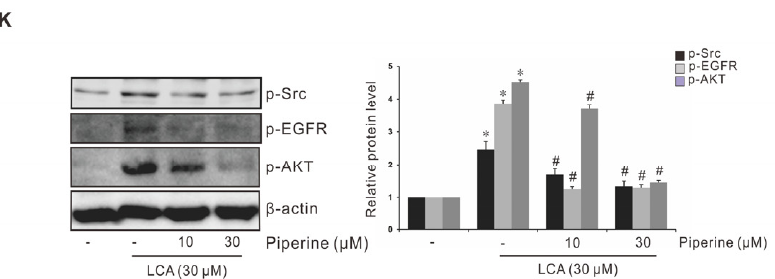
Figure 3. Piperine Inhibits LCA-Induced IL-8 Expression by Suppressing the Activation of ERK1/2, Src, AKT, and EGFR Signaling Pathways. ( A ) HCT-116 cells were pretreated with 30 µ M concentration of SB-203580 (SB), 30 µ M concentration of PD-98059 (PD), and 30 µ M concentration of JNKi for 1 h, and incubated with 30 µ M concentration of LCA for 4 h. Subsequently, the IL-8 mRNA level was measured through RT-qPCR. ( B ) HCT-116 cells pretreated with 30 µ M SB, 30 µ M PD, and 30 µ M JNKi for 1 h were incubated with 30 µ M LCA for 24 h followed by ELISA assay to determine the IL-8 expression level. ( C ) HCT-116 cells were transiently transfected with dominant-negative mutants of MEK-1 (K97 M), JNK (TAM67), or mutant p38 MAPK (mP38), and co-transfected with pGL2-IL-8. After incubation with 30 µ M LCA for 4 h, the luciferase activity was measured using a luminometer. ( D ) HCT-116 cells pretreated with 30 µ M SB, 30 µ M PD, or 30 µ M JNKi for 1 h were incubated with 30 µ M LCA for 4 h, and cell lysates were analyzed for the phosphorylated and total ERK level using western blotting. ( E ) HCT-116 cells pretreated with 5 mM NAC or 10 µ M DPI for 1 h were incubated with 30 µ M LCA for 4 h, and cell lysates were analyzed for the phosphorylated and total ERK level using western blotting. ( F ) HCT-116 cells were incubated with 30 µ M LCA for 0–60 min, and cell lysates were analyzed for levels of phosphorylated Src, AKT, and EGFR using western blotting. ( G ) HCT-116 cells pretreated with 10 µ M AG1478 (AG), 10 µ M PP1, 10 µ M PP2, and 20 µ M LY-294002 (LY) for 1 h were incubated with 30 µ M LCA for 4 h. Subsequently, the IL-8 mRNA level was measured using RT-PCR. ( H ) HCT-116 cells pretreated with 10 µ M AG, 10 µ M PP1, 10 µ M PP2, and 20 µ M LY for 1 h were incubated with 30 µ M LCA for 4 h, and the luciferase activity was measured using a luminometer. ( I ) Cells transfected with si-Con, si-Src, si-EGFR, and si-AKT were incubated with 30 µ M LCA for 4 h, and IL-8 mRNA level was measured using RT-PCR. ( J ) Effects of si-Src, si-AKT, and si-EGFR on LCA-stimulated IL-8 promoter activity in CRC cells. Cells transfected with si-Con, si-Src, si-EGFR, and si-AKT were incubated with 30 µ M LCA for 4 h, and the luciferase activity was measured using a luminometer. Data represent the mean ± SEM from three experimental trials. * p < 0.05 versus control; # p < 0.05 versus LCA only. ( K ) HCT-116 cells pretreated with piperine in a dose-dependent manner for 1 h were incubated with 30 µ M LCA for 30 min, and cell lysates were analyzed for the phosphorylated Src, EGFR, and AKT levels using western